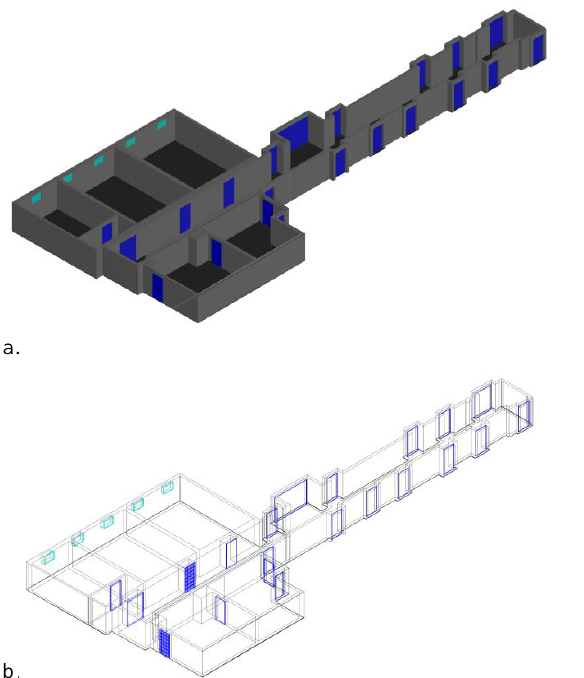
Figure 8. Results of the reconstruction of the indoor environment adopted as case study: (a) the reconstructed model without ceiling; and (b) a wireframe view of the same